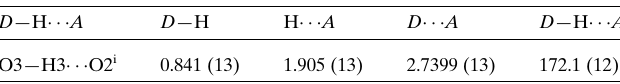
Table 2 Hydrogen-bond geometry (A˚ , (cid:3) ).